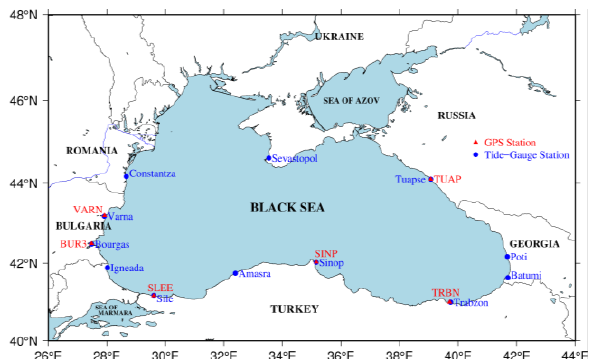
Figure 1. Data locations in the study: Tide-gauge stations (blue), GPS stations (red).